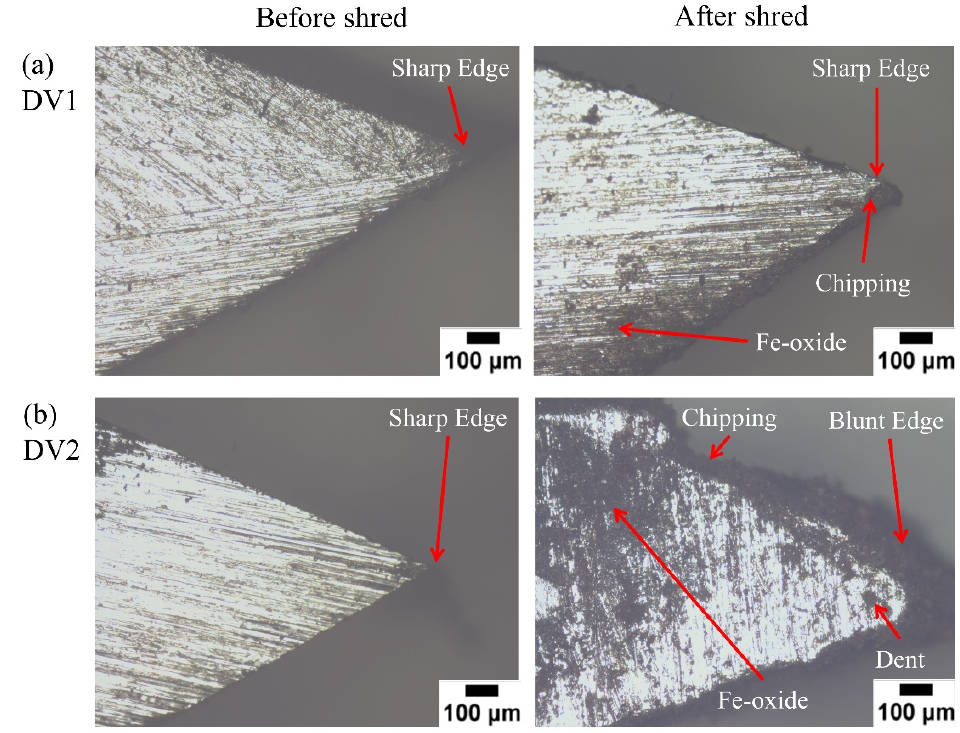
Figure 11. Optical microscope images of double-edge blades arranged in V-orientation, before and after shredding of the PET plastic: ( a ) DV1, ( b ) DV2.